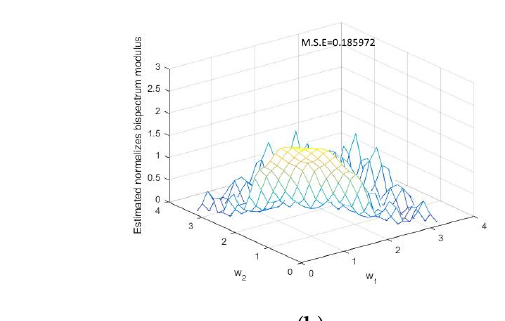
Figure 10. The estimated bispectrum modulus using the Parzen window. ( a ) Generated observations. ( b ) Forecasted observations.